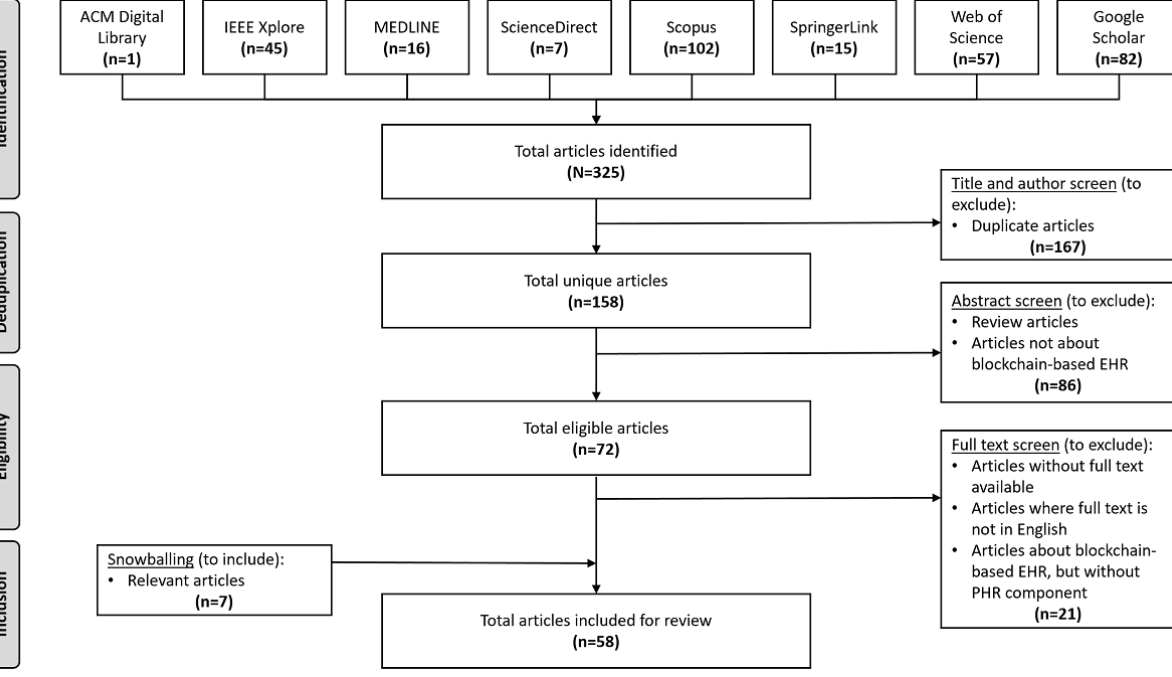
Figure 2. PRISMA (Preferred Reporting Items for Systematic Reviews and Meta-analyses) flow diagram of the article selection process. The title and author screen involved removing duplicate articles that had the same title and authors. The abstract screen involved reviewing article abstracts to remove review articles and those not related to blockchain and electronic health records. The full text screen involved reviewing the full articles to exclude those that did not meet the inclusion and exclusion criteria, and those whose full text was not available or in English. ACM: Association of